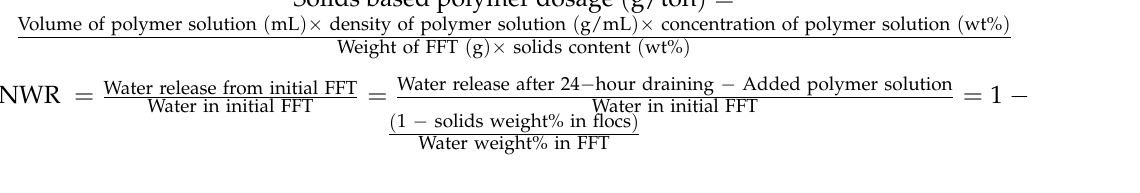
Figure 6. Dosage curves of 4 different FFT treated with polymer A3338: dosage curves are plotted by NWR versus solids based dosage. Each dot is the average value of duplicate or more testing results.